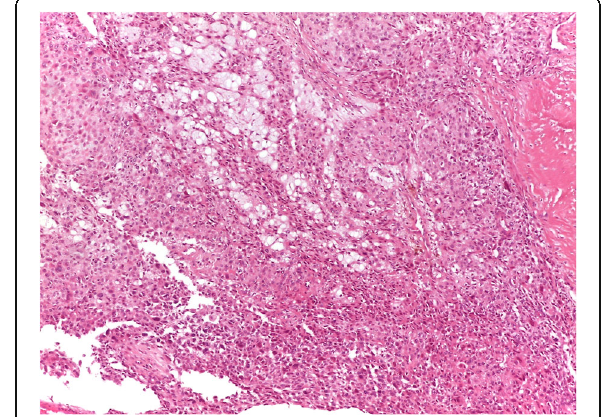
Fig. 2 Malignant mesenchymal epithelioid cells growing in solid nests and